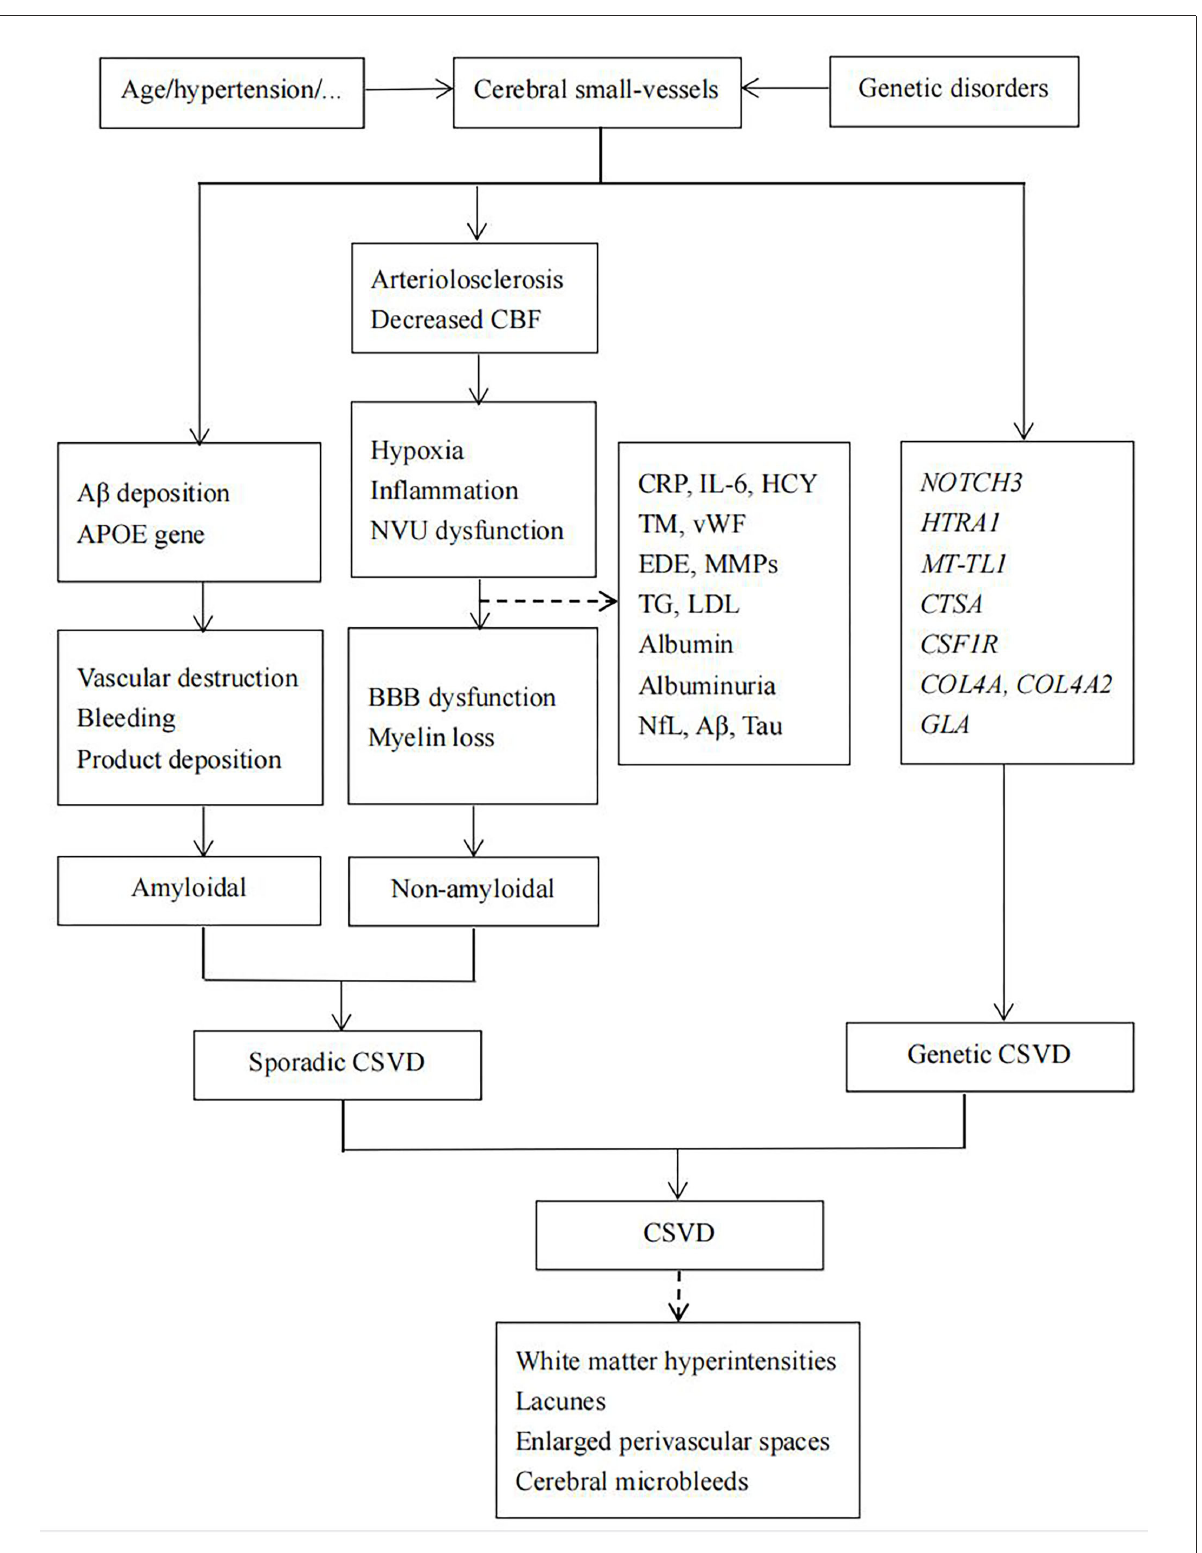
FIGURE1 Hypothesis about the pathogenesis of cerebral small-vessel disease (CSVD). BBB, blood–brain barrier; CSVD, cerebral small-vessel disease; CBF, cerebral blood